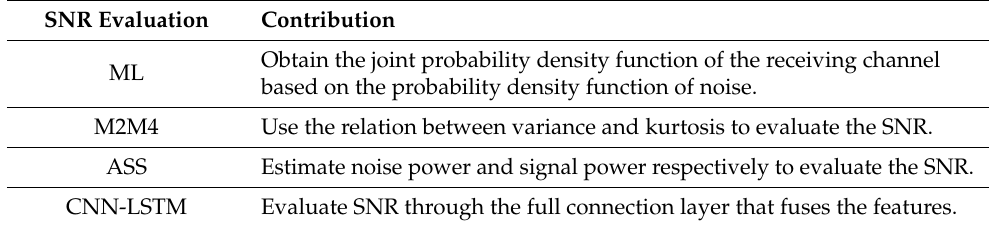
Table 1. The comparison of related signal-to-noise ratios (SNR) evaluation